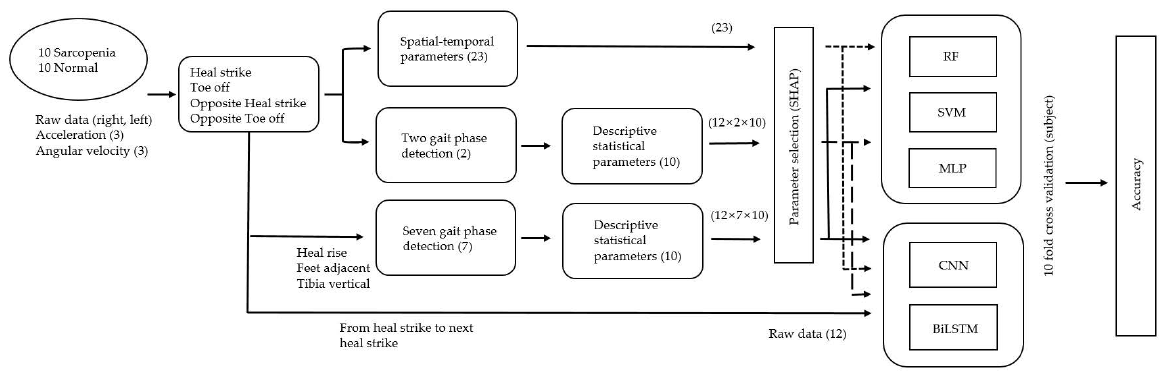
Figure 3. Data processing pipeline for the identification of